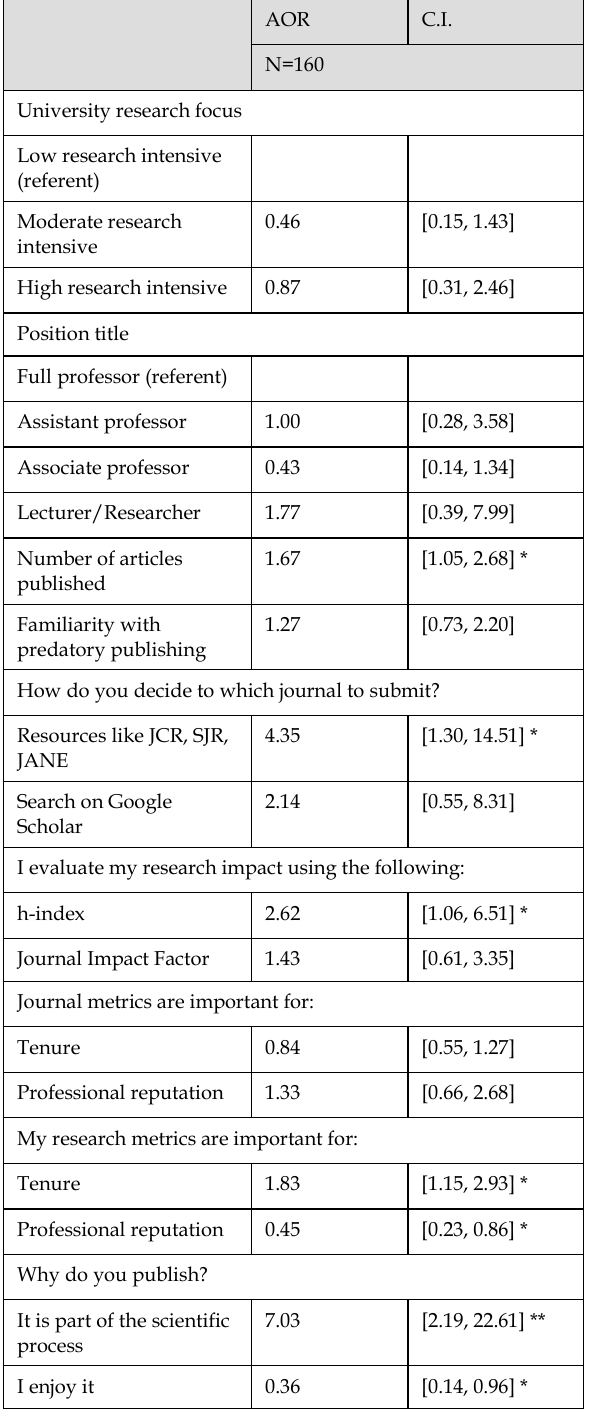
Table 4 Logistic regression results of article processing fees on participant characteristics and opinions